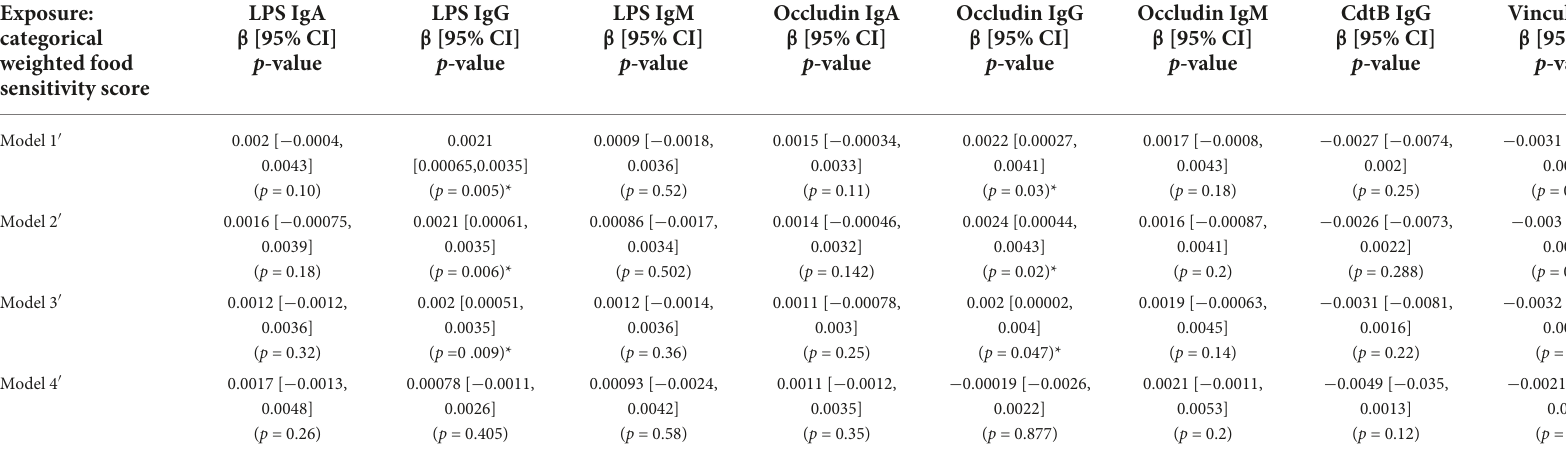
TABLE 5 Association between intestinal permeability biomarkers and categorical weighted food sensitivity score ( n = 111). Exposure: categorical weighted food sensitivity score